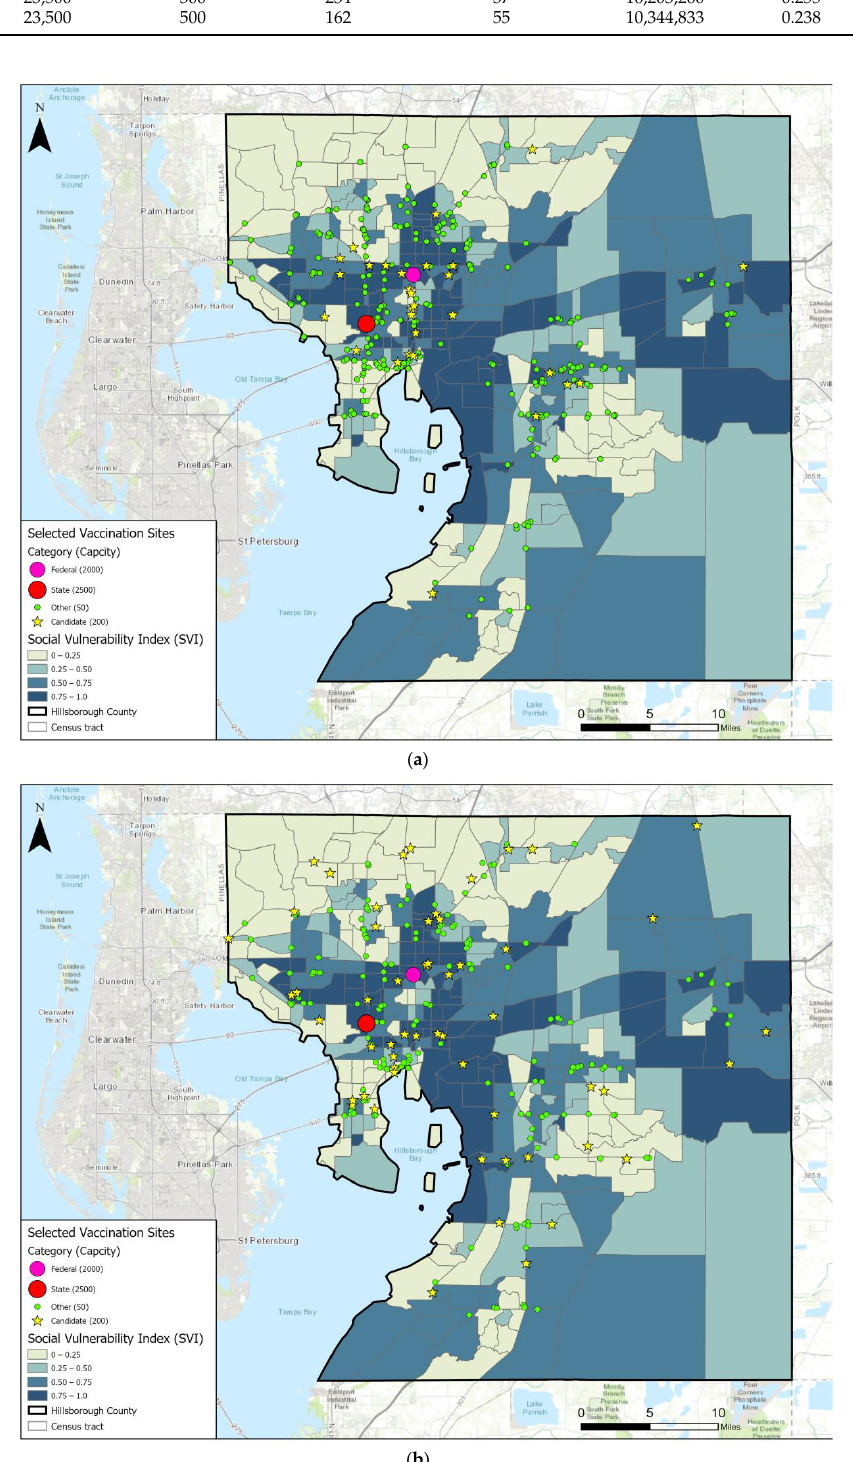
Figure 4. Case ( a , b ) result maps with selected vaccination site